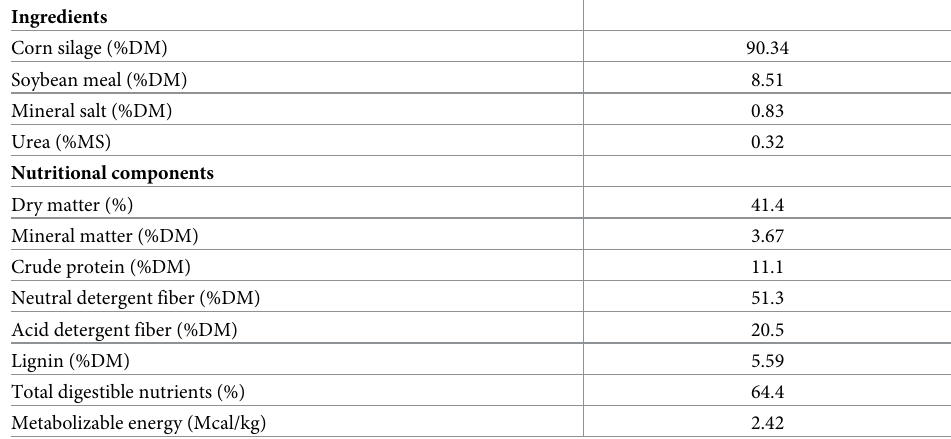
Table 2. Nutritional composition of the diet offered to lactating cows and calves.